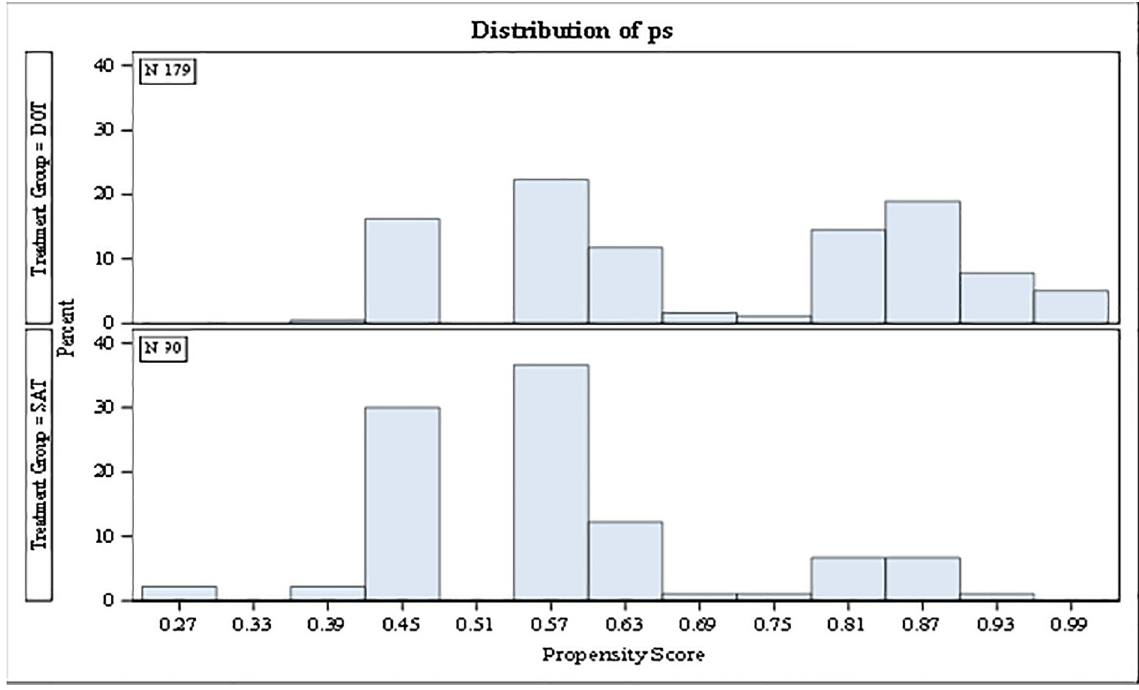
Fig 2. Histogram of propensity score distribution in the LTBI treatment groups.